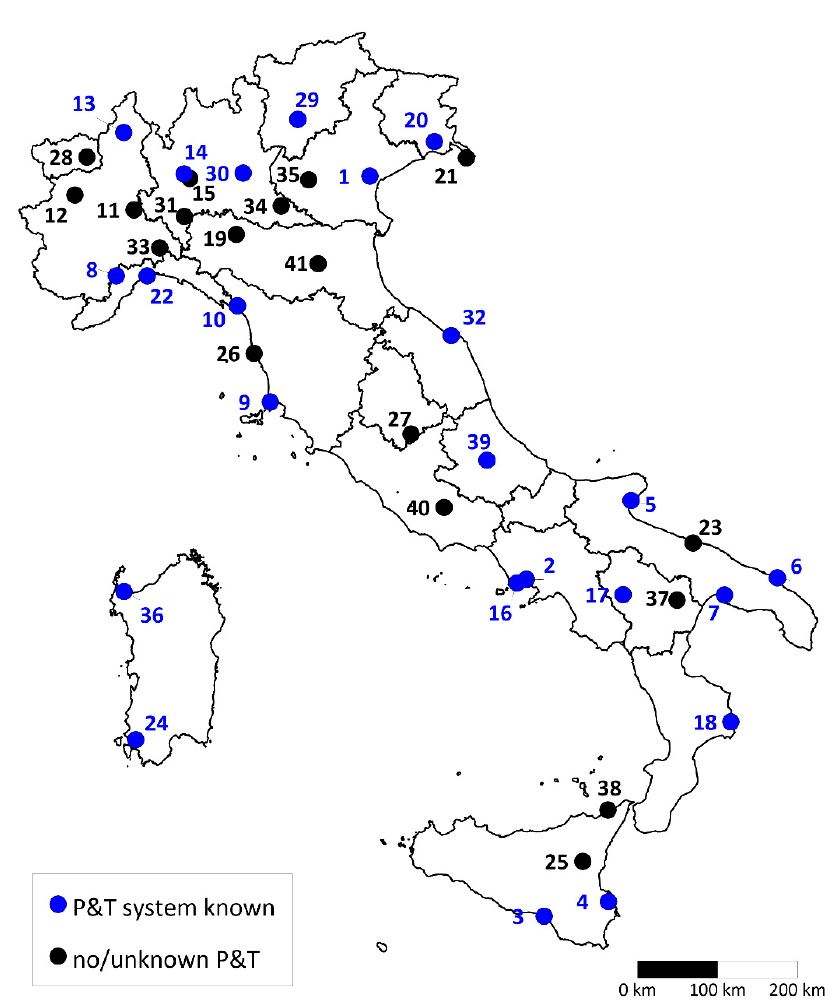
Figure 4. Map of the 41 “Siti di Interesse Nazionale (SIN)” (contaminated Sites of National Interest). For numbering, refer to Appendix C.